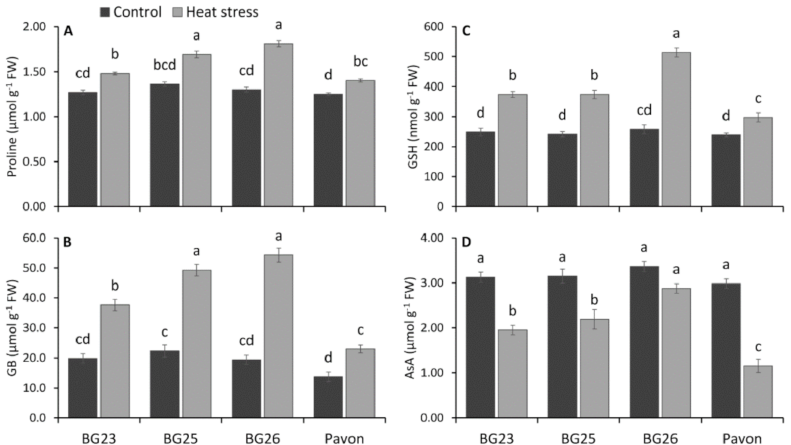
Figure 4. Changes in osmolytes and non-enzymatic antioxidants- ( A ) proline, ( B ) glycine betaine (GB), ( C ) glutathione (GSH) and ( D ) ascorbate (AsA) content of wheat varieties under control and heat-stressed conditions. Vertical bars represent +/ − SE values. Different letter(s) indicate significant difference at p <